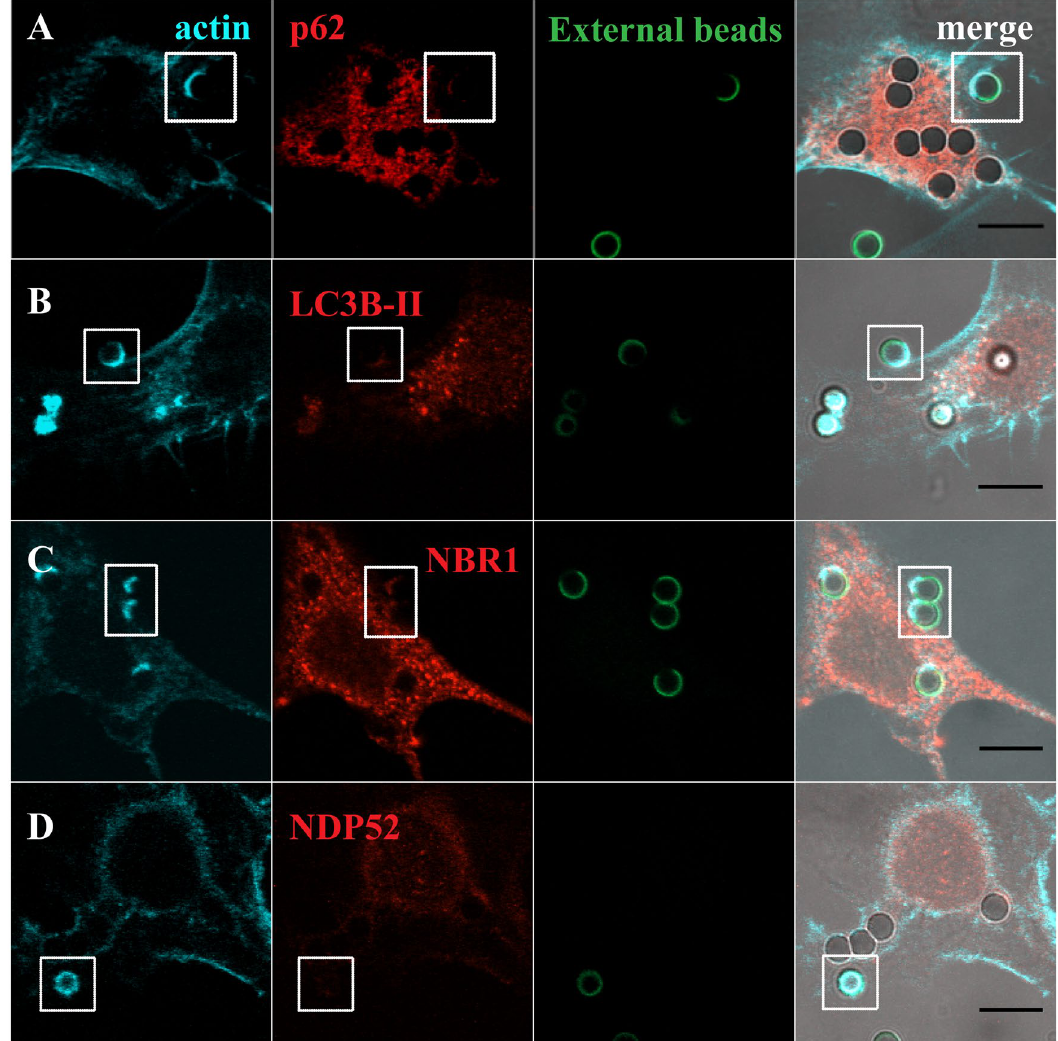
Figure 3. Co-localization of LC3B-II and autophagy effectors in phagocytic cups of IgG-opsonized particles. Non-professional phagocytes were fed with IgG-opsonized beads for 30 min, fixed, and co-stained for F-actin with Phalloidin and for the endogenous LC3B or autophagy adaptors. ( A – D ) are representative images of cells co-stained for F-actin and p62 ( A ), LC3B ( B ), NBR1 ( C ) or NDP52 ( D ). The first column represents cells stained for F-actin. The second column represents cells stained for the endogenous p62, LC3B-II, NBR1 or NDP52. The third column shows non-internalized beads stained with an anti-human IgG antibody conjugated with FITC. The fourth column represents merged images of F-actin with LC3B-II or autophagy adaptors and the opsonized latex beads (external and internal beads visualized by DIC). The regions outlined by the boxes are phagocytic cups formed upon the recognition of IgG-opsonized particles by the Fc-receptors. Bars, 10 µ